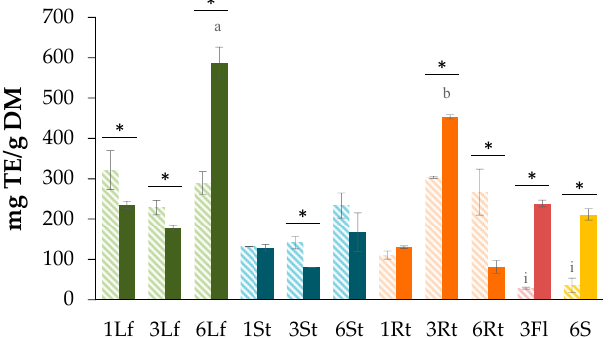
Figure 4. Ferric-reducing antioxidant power (FRAP) assay C. quinoa processed by air-drying (dash bars) and freeze-drying (dark bars) at di ff erent times after seeding (1, 3, 6 months) of di ff erent plant parts (leaves (Lf), stems (St), roots (Rt), seeds (S), and flowers (Fl)). Each bar represents the mean ± standard deviation ( n = 3). Significant di ff erences between plant parts and harvesting times ( p = 0.026865 > 0.01). Letters represent significant di ff erences between treatments analyzed by the Tukey test ( p = 0.05). * p < 0.05 when compared between drying methods.